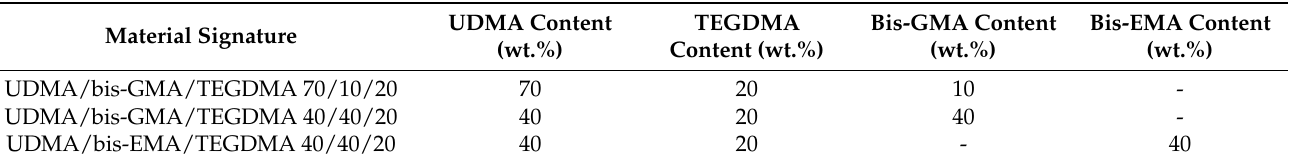
Table 1. Composition of tested matrices. Composites used in this study have the same resin composi- tions and contain 45 wt.% of silanized